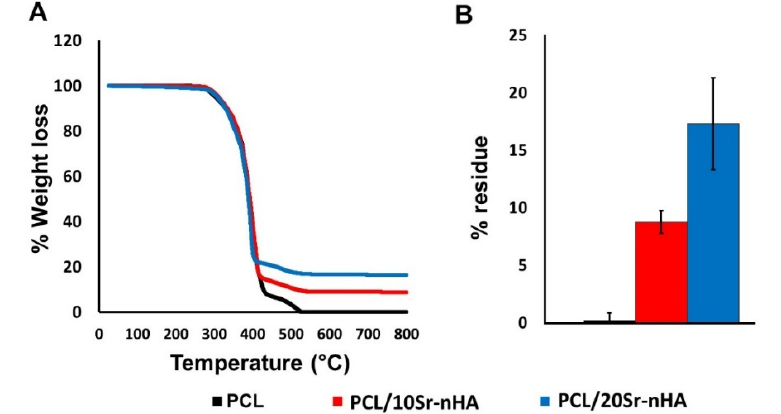
Figure 3. ( A ) TGA curves for the 3D printed filaments and ( B ) resulting ceramic residues (%) after the extrusion extrusion process.